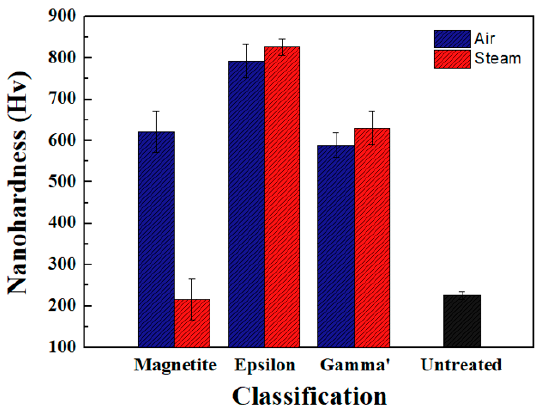
Figure 7. Nanohardness of each phase for three different specimens measured by nanoindentation with an applied load of 10 mN.